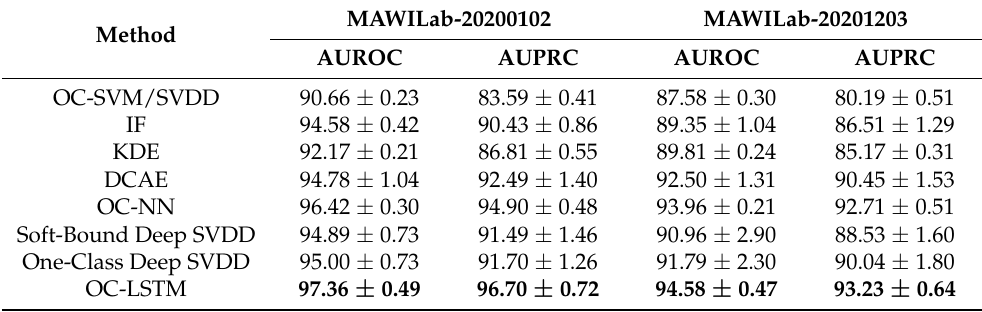
Table 5. Average AUROC and AUPRC values as percentages with StdDevs per method on